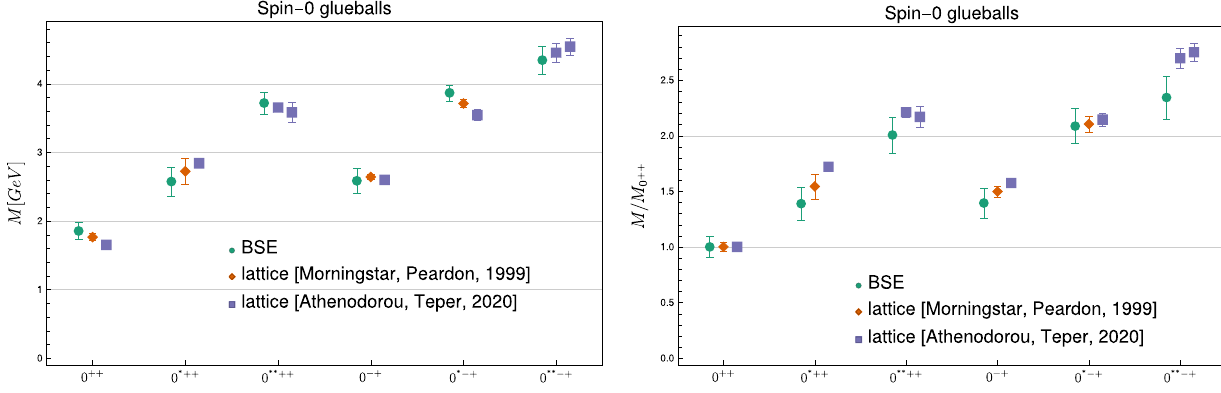
Fig. 7 Results for scalar and pseudoscalar glueball ground states and excited states from lattice simulations [4,6] and this work. In the left diagram we display the glueball masses on an absolute scale set by r 0 = 1 /( 418 ( 5 ) MeV ) . In the right diagram we display the spectrum relative to the ground